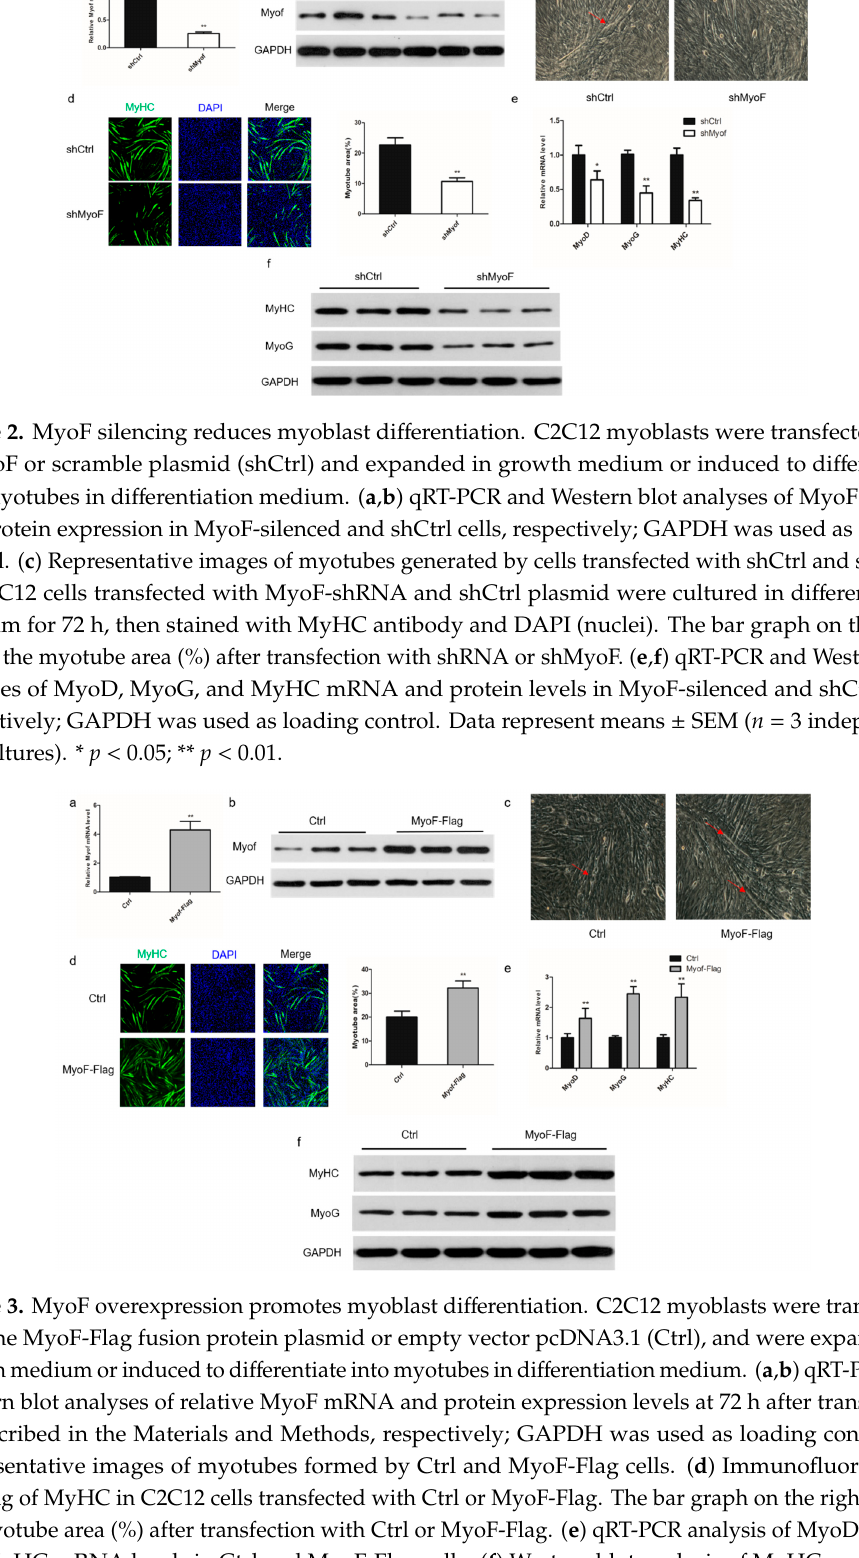
Figure 3. MyoF overexpression promotes myoblast di ff erentiation. C2C12 myoblasts were transfected with the MyoF-Flag fusion protein plasmid or empty vector pcDNA3.1 (Ctrl), and were expanded in growth medium or induced to di ff erentiate into myotubes in di ff erentiation medium. ( a , b ) qRT-PCR and Western blot analyses of relative MyoF mRNA and protein expression levels at 72 h after transfection as described in the Materials and Methods, respectively; GAPDH was used as loading control. ( c ) Representative images of myotubes formed by Ctrl and MyoF-Flag cells. ( d ) Immunofluorescence staining of MyHC in C2C12 cells transfected with Ctrl or MyoF-Flag. The bar graph on the right shows the myotube area (%) after transfection with Ctrl or MyoF-Flag. ( e ) qRT-PCR analysis of MyoD, MyoG, and MyHC mRNA levels in Ctrl and MyoF-Flag cells. ( f ) Western blot analysis of MyHC and MyoG protein levels in Ctrl and MyoF-Flag cells; GAPDH was used as loading control. Data represent means ± SEM ( n = 3 independent cell cultures). * p < 0.05; ** p <